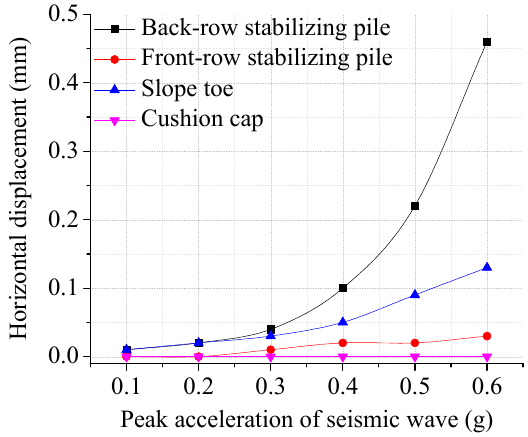
Figure 12. Horizontal displacement curves. Figure 13. Pile cracks.